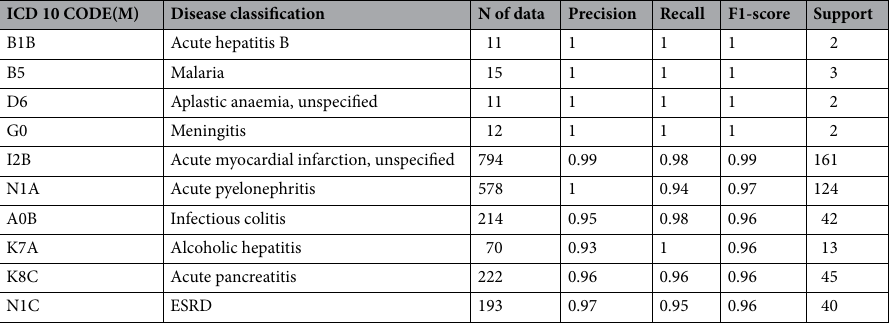
Table 2. Ensemble model TOP 10 result using F1 score performance measure. M modified.